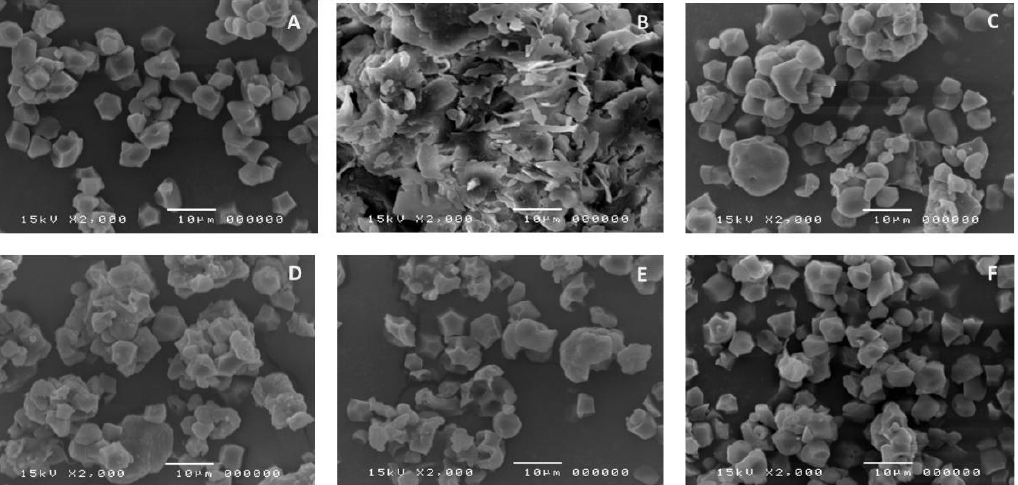
Figure 2. SEM Images of ( A ) Native, ( B ) Pre-gelatinized, ( C ) Carboxymethyl, ( D ) Crosslinked Carboxymethyl, ( E ) Crosslinked, and ( F ) Hydroxypropyl Starches Derived from KJ CMU-107 Rice Starch. Images Taken at 2000 ×